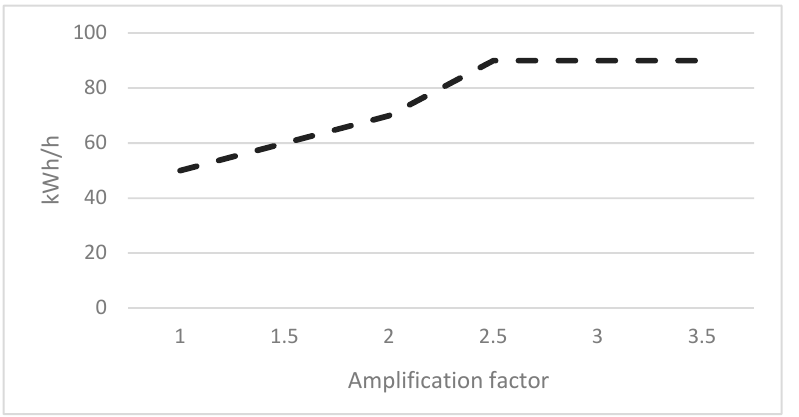
Figure 5. Battery capacity requirement under different demand levels given a battery cost of 6000 NOK/kWh. Amplification factor 1 means the current situation, while 2 refers to a situation where demand (as associated with the arrival rate in each hour) is doubled.